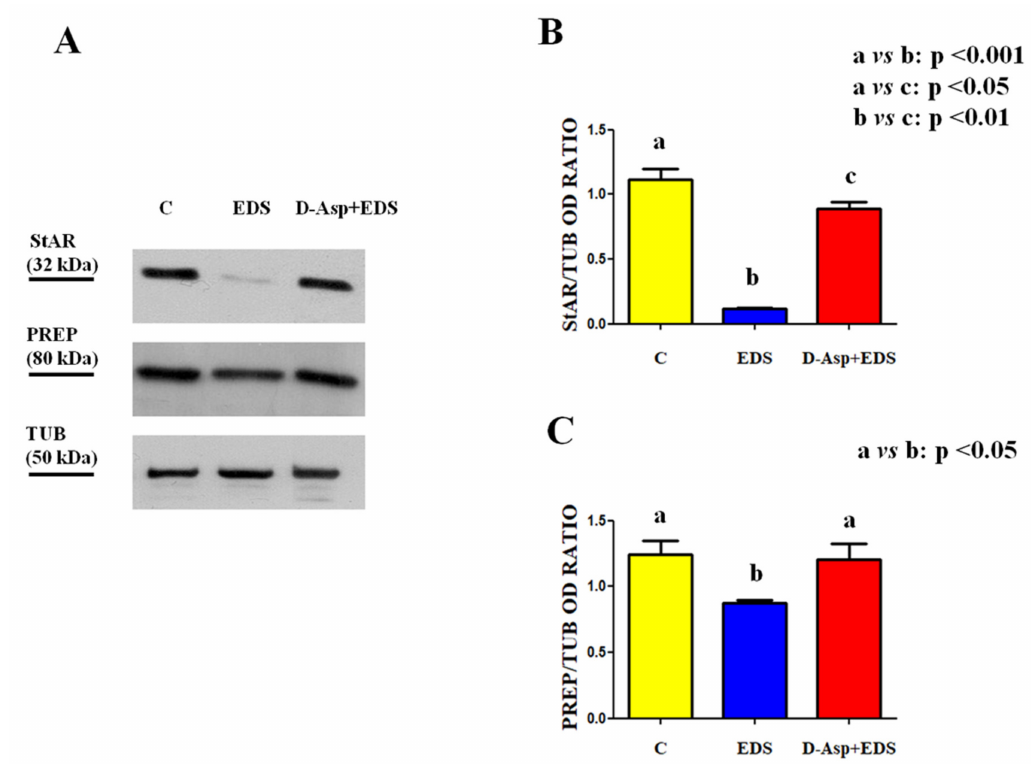
Figure 3. Testicular steroidogenic acute regulatory (StAR) and prolyl endopeptidase (PREP) protein levels in EDS and D-Asp + EDS treated rats. ( A ) Western blot analysis of StAR (32 kDa) and PREP (80 kDa) protein levels in the testis from control, EDS, and D-Asp + EDS treated rats. ( B ) The amount of StAR was quantified using ImageJ program and normalized with respect to α -tubulin (50 kDa). ( C ) The amount of PREP was quantified using ImageJ program and normalized with respect to α -tubulin (50 kDa). Values are expressed as mean ± SEM from 5 animals in each